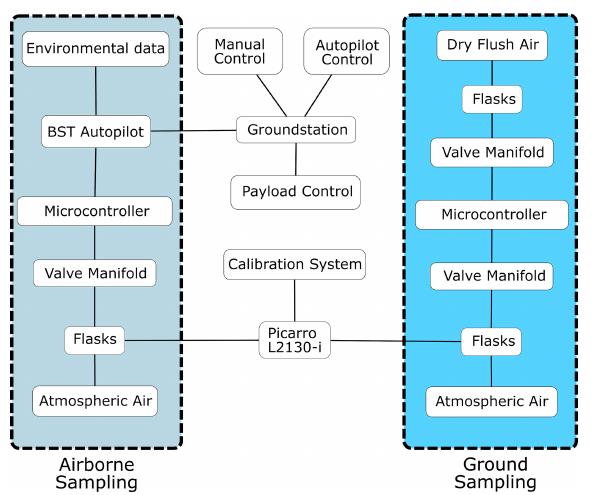
Figure A1. UAV-isotope system diagram showing control and sam- ple exchange between airborne/ground sampling and measurement subsystems. Both ground and airborne sampling are performed identically, though their control methods